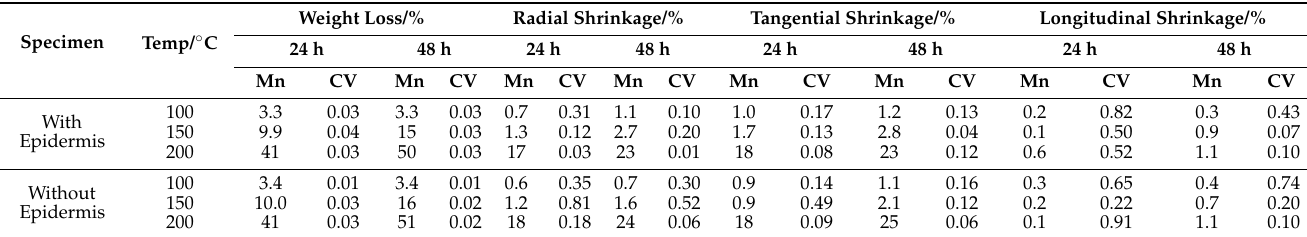
Figure 5. The percentage weight loss (including R 2 values) of test specimen: ( a ) with epidermis and ( b ) with planed epidermis subjected to heat treatment at three different temperatures for 24- and 48-h duration. Table 1. Weight and dimensional changes of Moso bamboo specimens during thermal modification at three different temperatures (Mn and CV represent the mean and coefficient of variance, respectively).